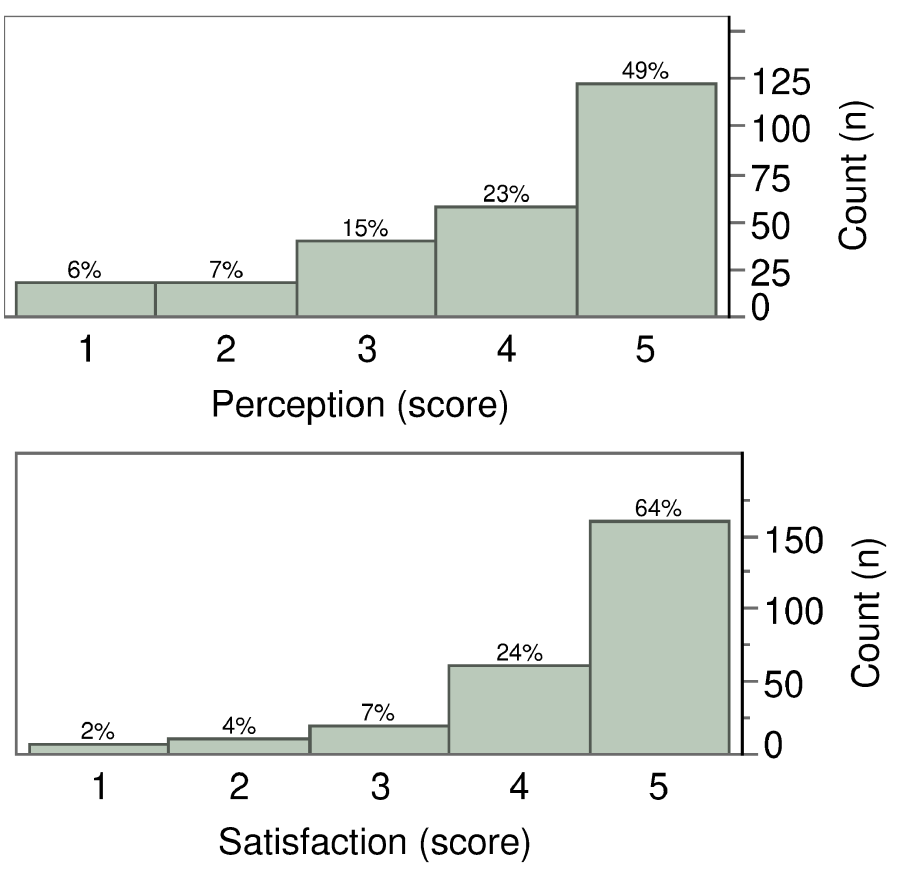
Fig 2. Distribution of the scores expressed by patients regarding their “Perception” of (A) and “Satisfaction” with (B) the telemedicine service. Scores were given on a five-point scale, from 1 (very low) to 5 (very high). The percentage of the sample is given above each